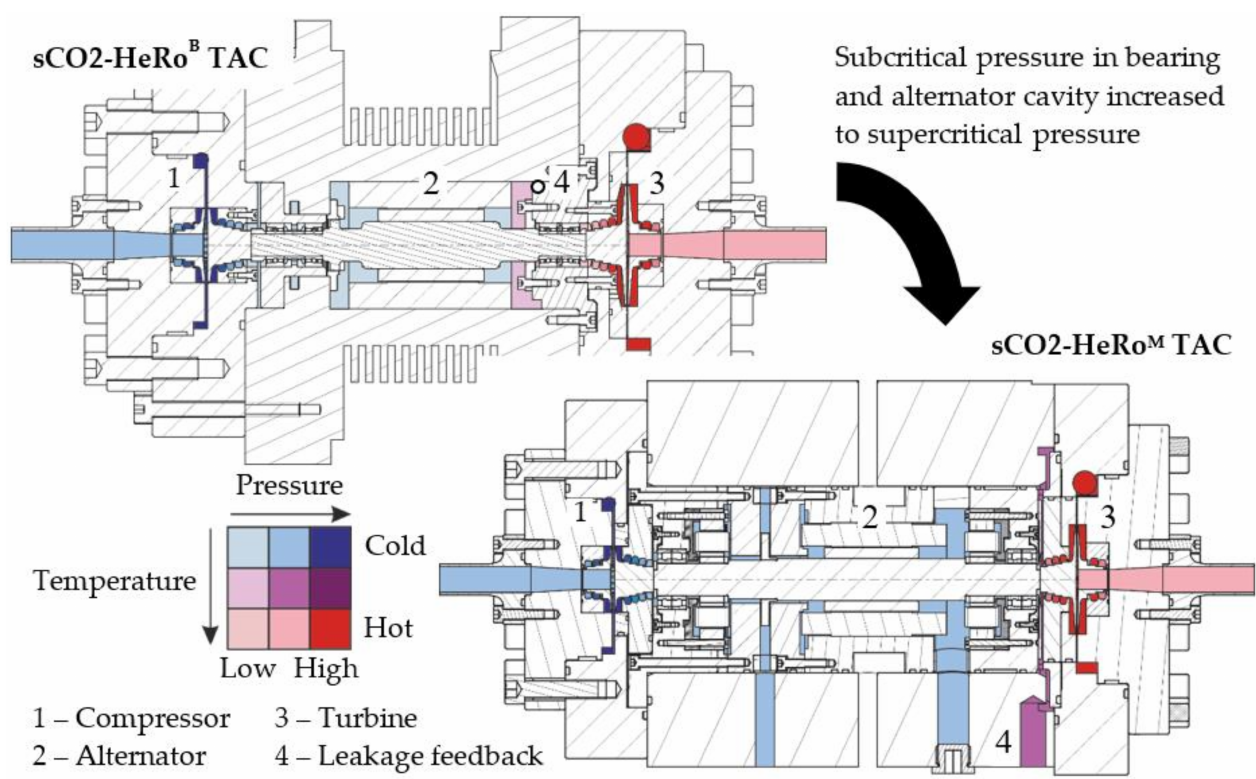
Figure 1. Cross-sections of sCO2-HeRo B TAC [3] ( top left ) and sCO2-HeRo M TAC ( bottom right ) with indication of CO 2 pressure and temperature inside rotor stator